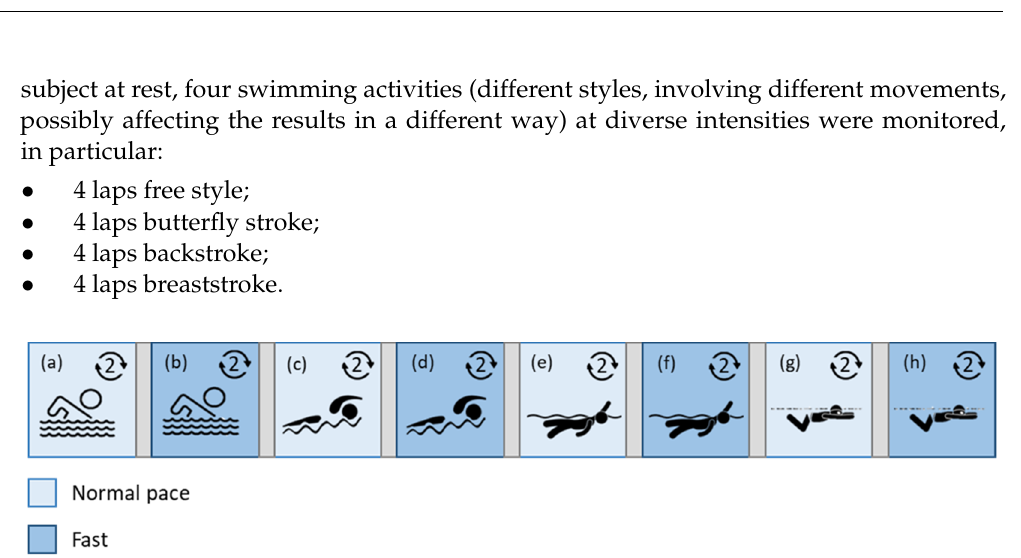
Figure 3. In-water test protocol (after initial recordings at rest): free-style ( a , b ), butterfly ( c , d ), back- stroke ( e , f ), and breaststroke ( g , h ) laps, at two diverse paces (normal and fast). For each swimming stroke, 4 laps were performed with different intensities: the first Data were processed in MATLAB environment. At first, data were pre-processed; in subjective, but this was done to experiment two different conditions, more challenging